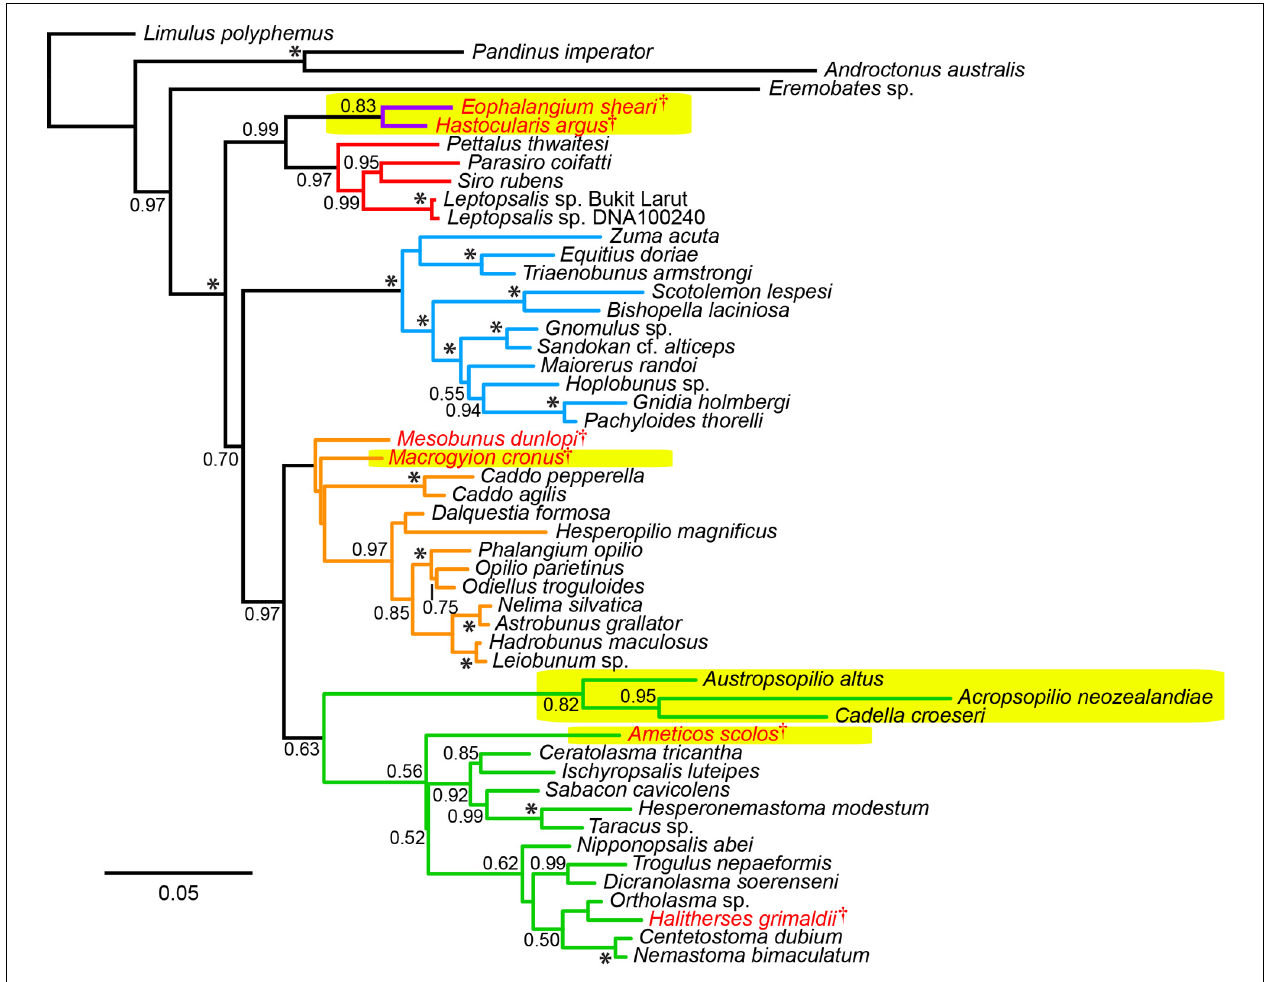
FIGURE 2 | Uncalibrated total evidence tree topology. Colors in tree correspond to suborders (purple: Tetrophthalmi; red: Cyphopthalmi; blue: Laniatores; orange: Eupnoi; green: Dyspnoi). Fossil taxa indicated in red lettering. Major recent amendments to Opiliones systematics are indicated in yellow highlights: discovery of